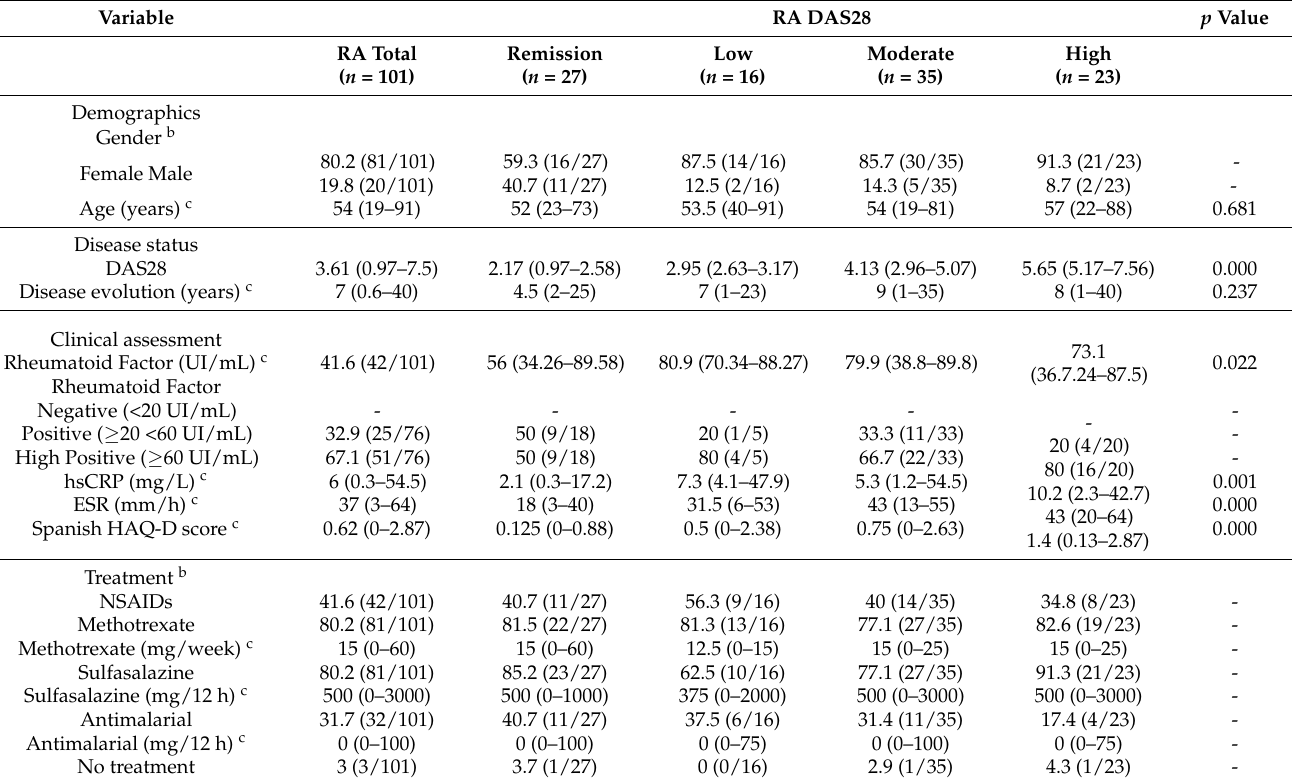
Table 1. Clinical and demographic features of RA